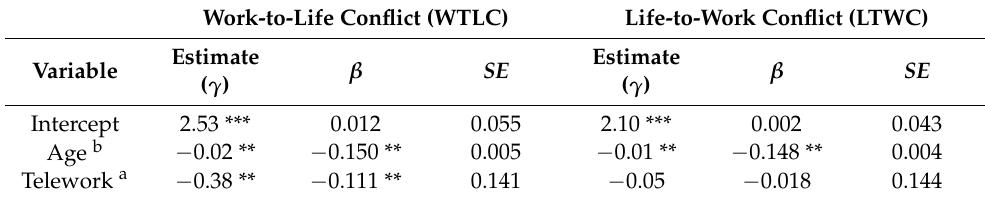
Table 3. Comparison depending on the direction of work–life